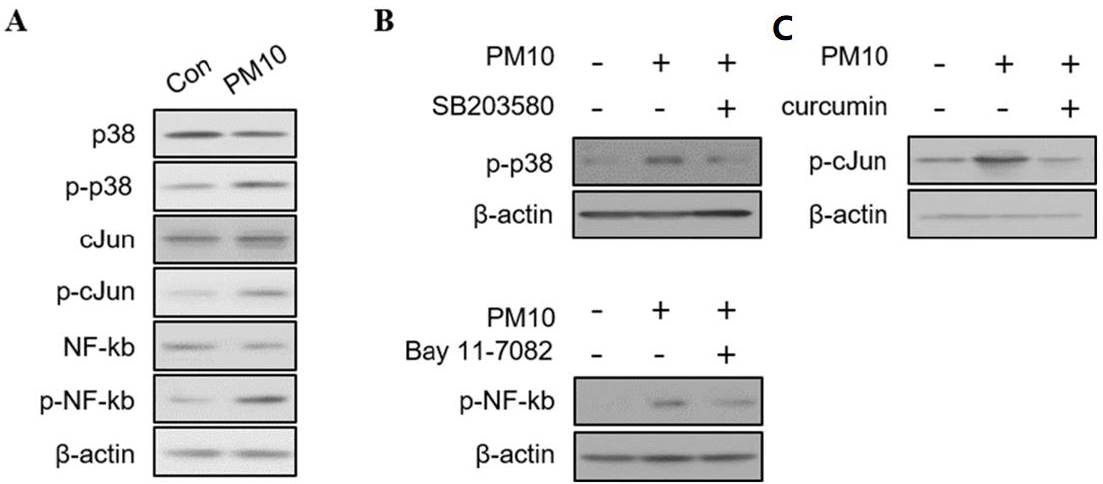
Figure 3. The immunoblotting results of signaling pathways in human nasal polyp derived fibroblast (NPDFs) after exposure to PM10. ( A ) Western blots of cytoplasmic proteins with antibodies to MAPKs (p38), AP-1 (c-Jun), and NF- kB in PM10 (200 μg/mL) -treated NPDFs for 1 h. ( B ) The ratio of phosphorylation of p38, c-Jun, and NF-kB by adding their respective inhibitors (SB203580 for p38, curcumin for c-Jun, bay 11-7082 for NF- kB). β -actin was used as an internal control. The phosphorylated protein band values were normalized to total protein bands. ( C ) The mRNA expression and protein levels of IL-6, IL-4, IL-33, and CXCL-1 were significantly inhibited by the addition of inhibitors to PM10-treated NPDFs. Relative intensities of blot bands were measured with Image J software. The graphic data represents the means ± SEM ( n = 5).